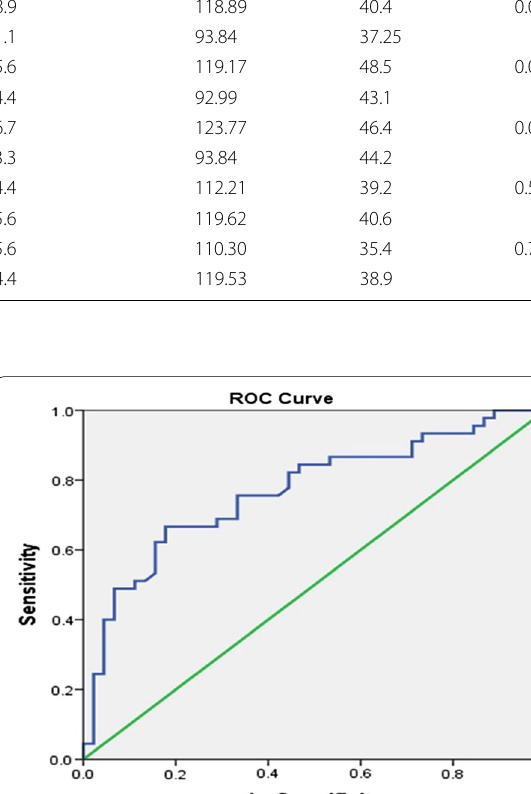
Table 7 Correlation between demographic, clinical, laboratory, radiological parameters and copeptin level